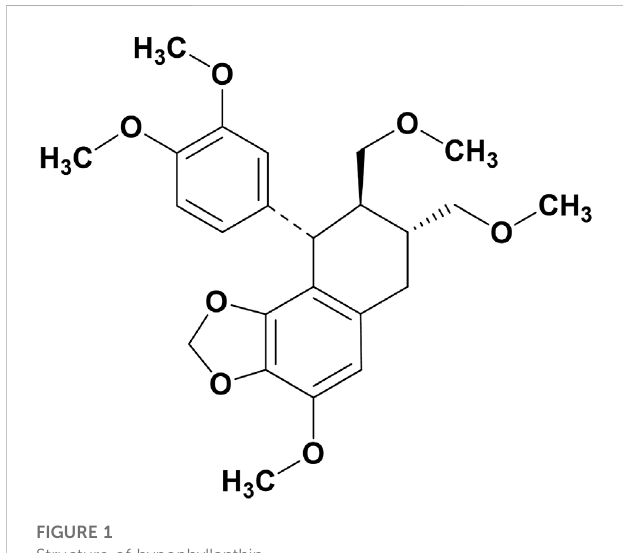
FIGURE 1 Structure of